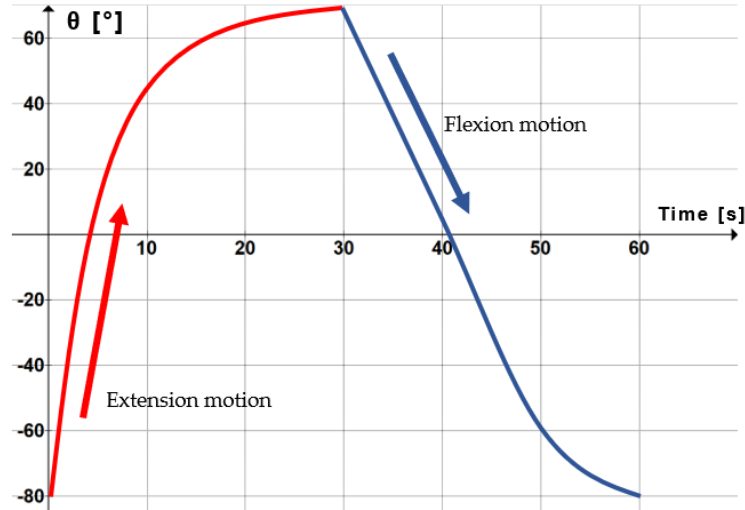
Figure 5. Sequence of recovery motions to be generated by the equipment.